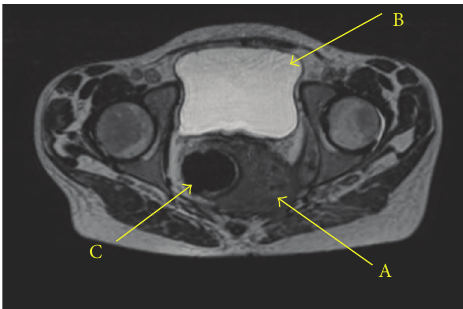
Figure 2: MRI scan of the small pelvic. A mass, originating from the perianal region, is expanding along the endopelvic fascia to dorsolateral with ingrowth in the left m. obturatoria and m. piriformis and ventral in the m. gluteus (Capitol A). No bladder ingrowth visible (Capitol B). The mass does have a direct relation with the wall of the lower rectum (Capitol